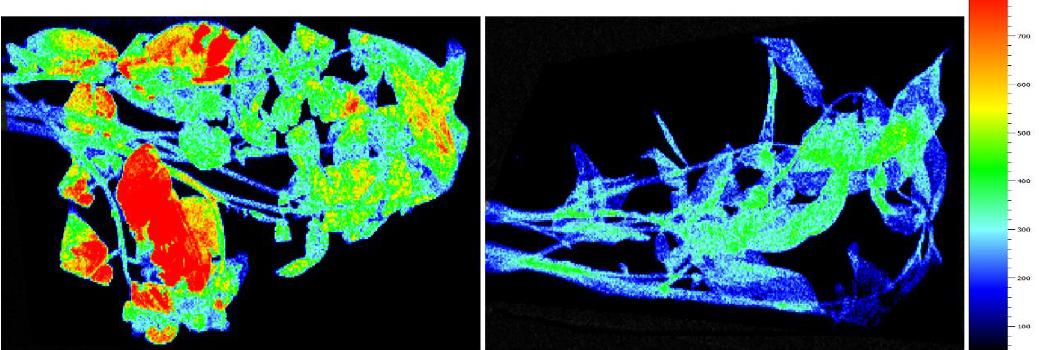
Figure 3. Fluorescence images (F m measurements) of control ( left ) and M. incognita -infected ( right ) tomato leaves.